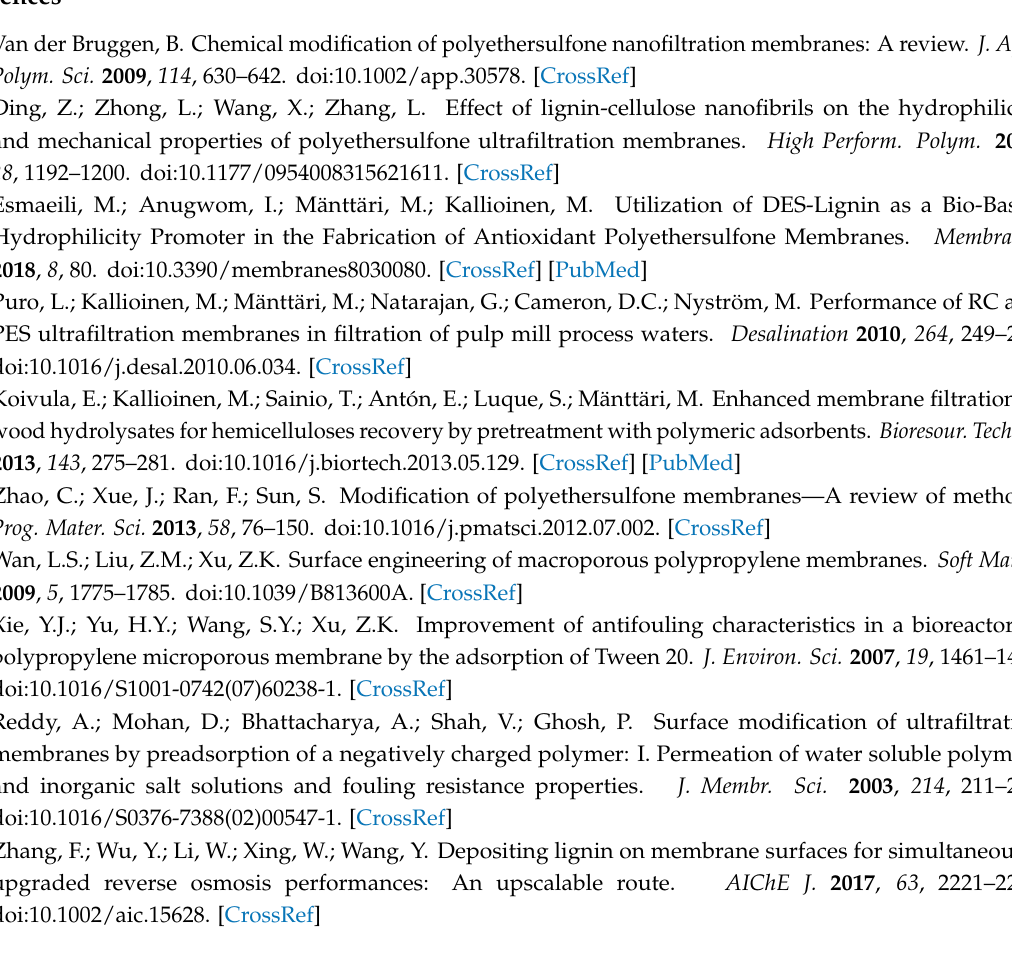
Figure S1: PEG solution permeabilities before and after modification with vanillin. Polyethersulfone membranes (UH004 P) were modified by different concentration of vanillin (0.3 g/L, 0.8 g/L and 1.3 g/L) and each experiment was repeated thrice. Figure S2: PEG solution permeabilities before and after modification with vanillin. Polyethersulfone membranes (UH004 P) were modified by different concentration of vanillin (1.8 g/L, 2.3 g/L and 2.8 g/L) and each experiment was repeated twice. Figure S3: The UV absorption of vanillin in different concentrations at wavelength of 308 nm and pH